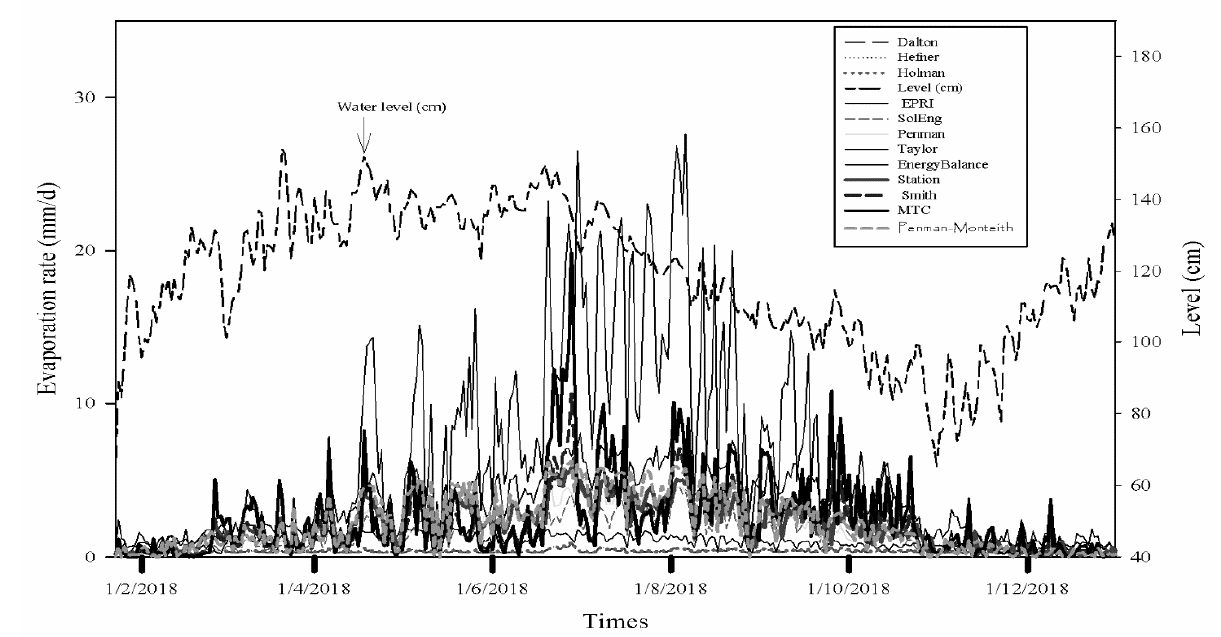
Figure 8. Estimation of daily evaporation rate by different methods from Thomas Pond.